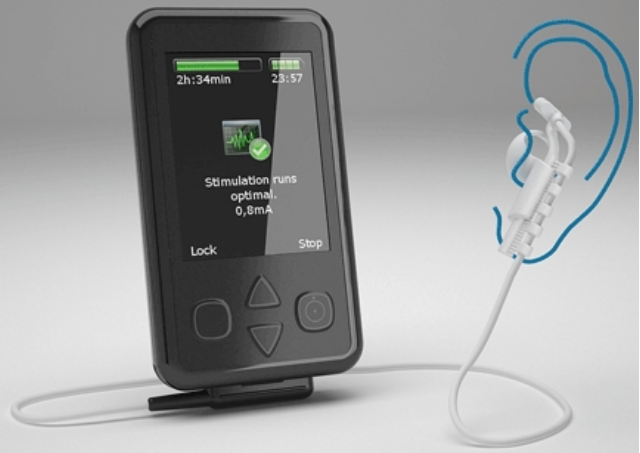
Figure 12. Transcutaneous Vagus Nerve Stimulation device for epilepsy control [63] (Image reprinted with kind permission of tVNS Technologies